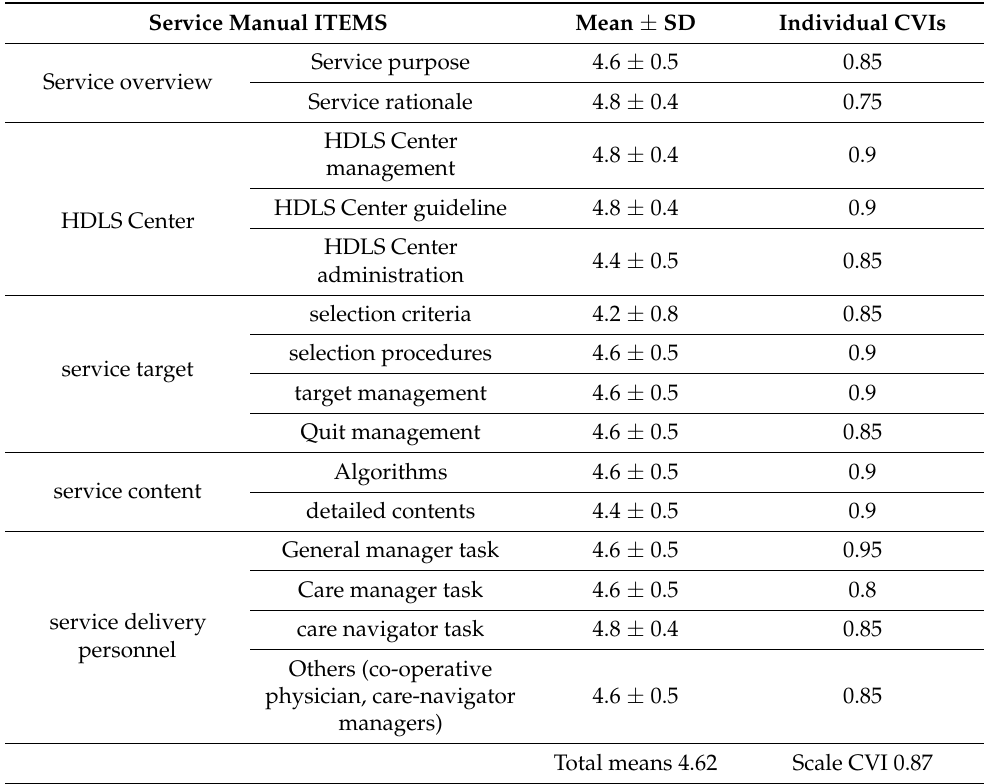
Table 1. Item means and individual content validity index (CVI) for the Community-Based Integrated Service (CBIS) model service